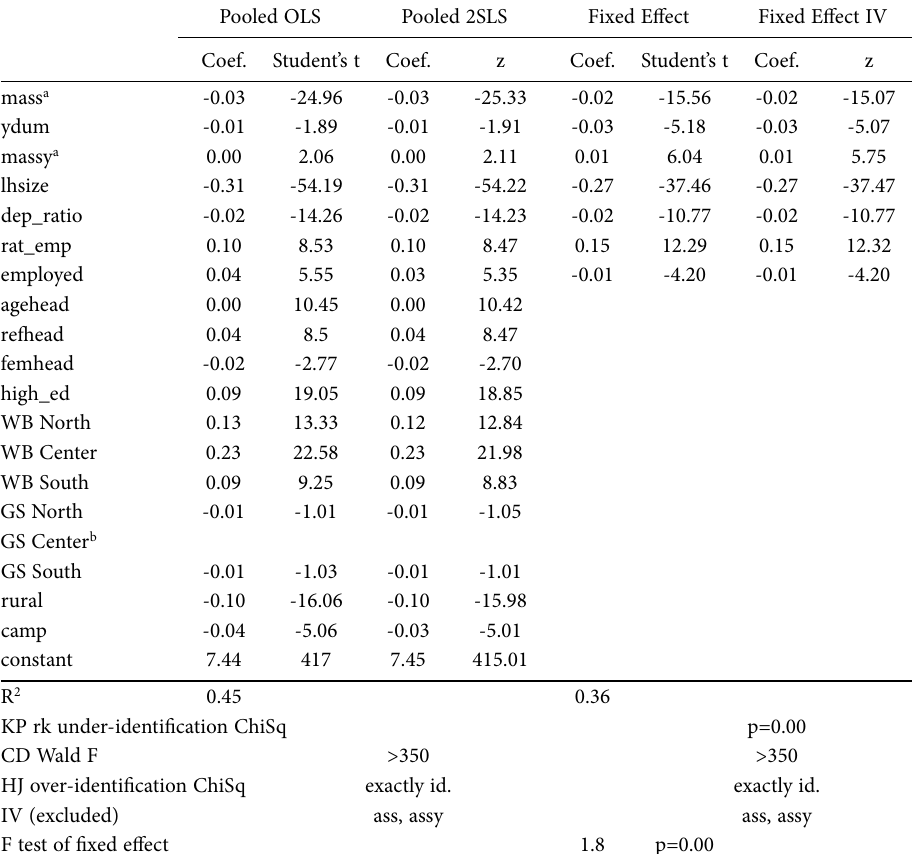
Table 9. Asset-based poverty index regression models, Palestine. Pooled